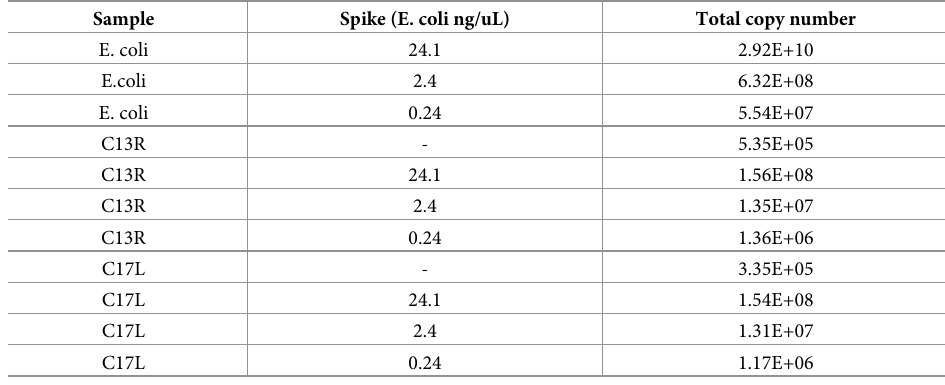
Table 2. Test of inhibition of 16S amplification by host tissue DNA using qPCR (see methods).